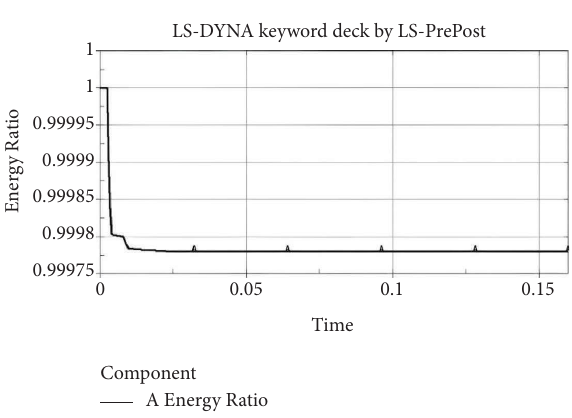
Figure 18: Energy